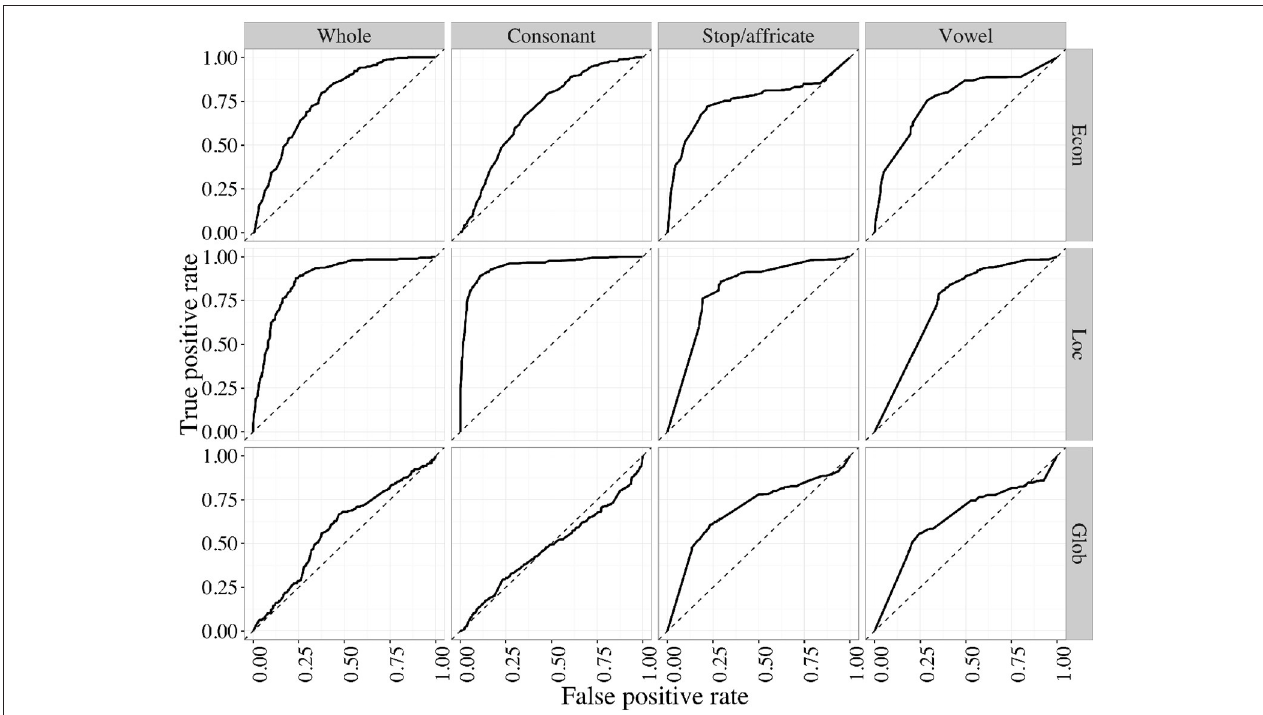
FIGURE 5 | Receiver operating characteristics for natural vs. random inventories, using each of the three geometric properties as decision criteria, within each of the four kinds of inventory